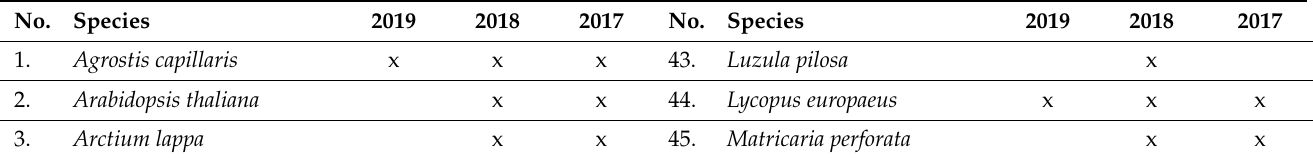
Figure A12. Scree plot from PCA analyses. Table A1. Observed species in study area during the three-year study.